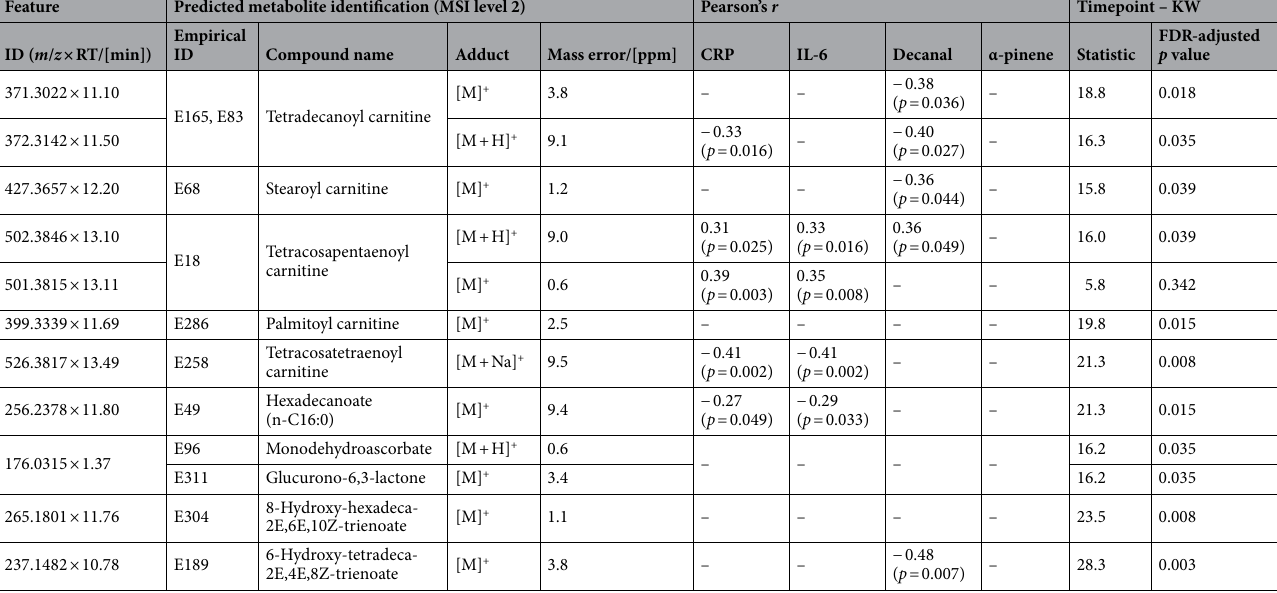
Table 3. List of features with metabolite identifications from molecular networking analysis, with Pearson’s correlation coefficients for inflammatory markers and breath decanal, and PC-DFA